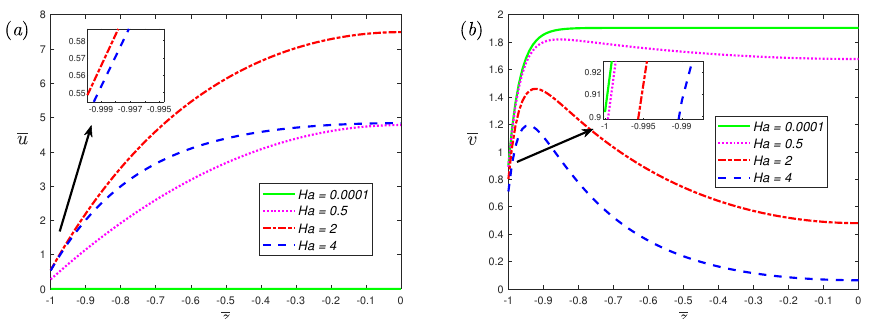
Figure 7. The absolute value of dimensionless velocity, ( a ) spanwise; ( b ) streamwise, for fractional Maxwell model across half channel width for different dimensionless parameters Ha at α = 0.7, β = 1, K = 30, L = 0.03, De = 5, ω = 0.